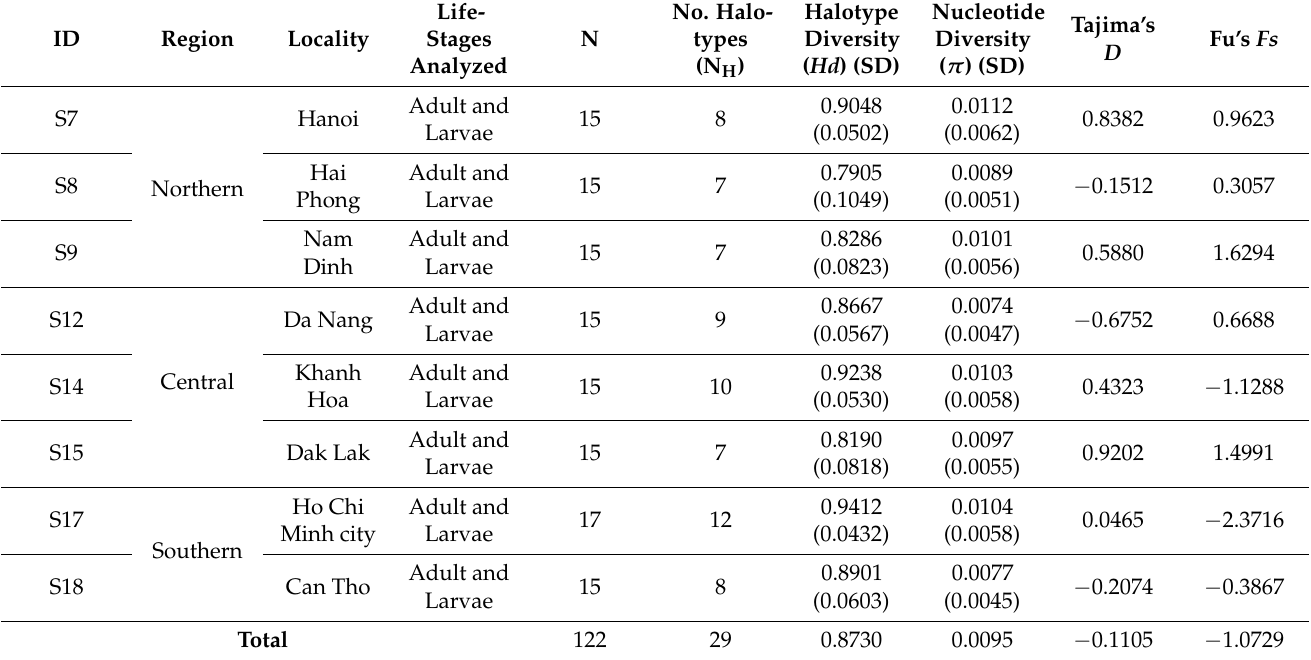
Table 3. Genetic diversity indices of Aedes aegypti from selected study sites in Vietnam, based on COI sequences (n =